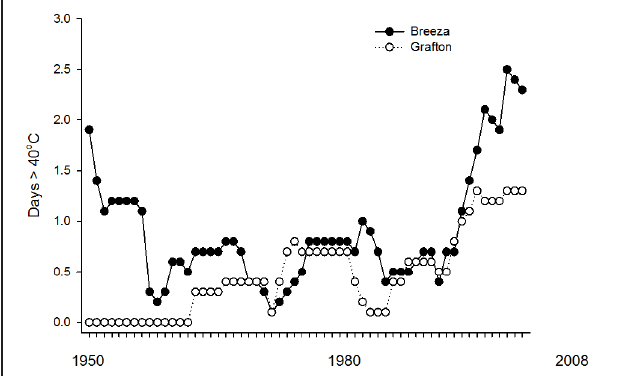
FIGURE 3 | Ten-year moving averages for number of days per year exceeding 40 ◦ C based on historical temperature (1950–2008) at Breeza and